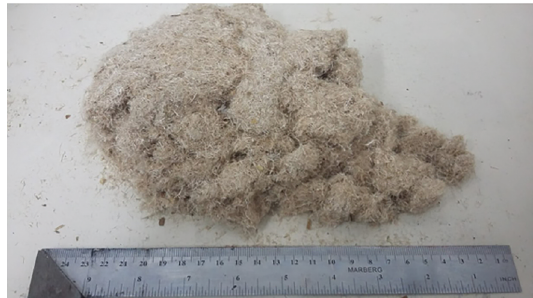
Figure 1. Curaua